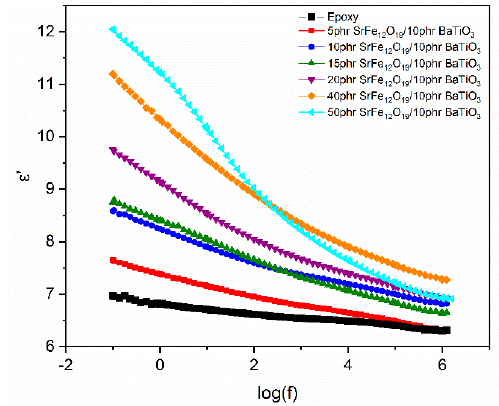
Figure 4. Real part of dielectric permittivity as a function of frequency, at 30 ◦ C, for all studied